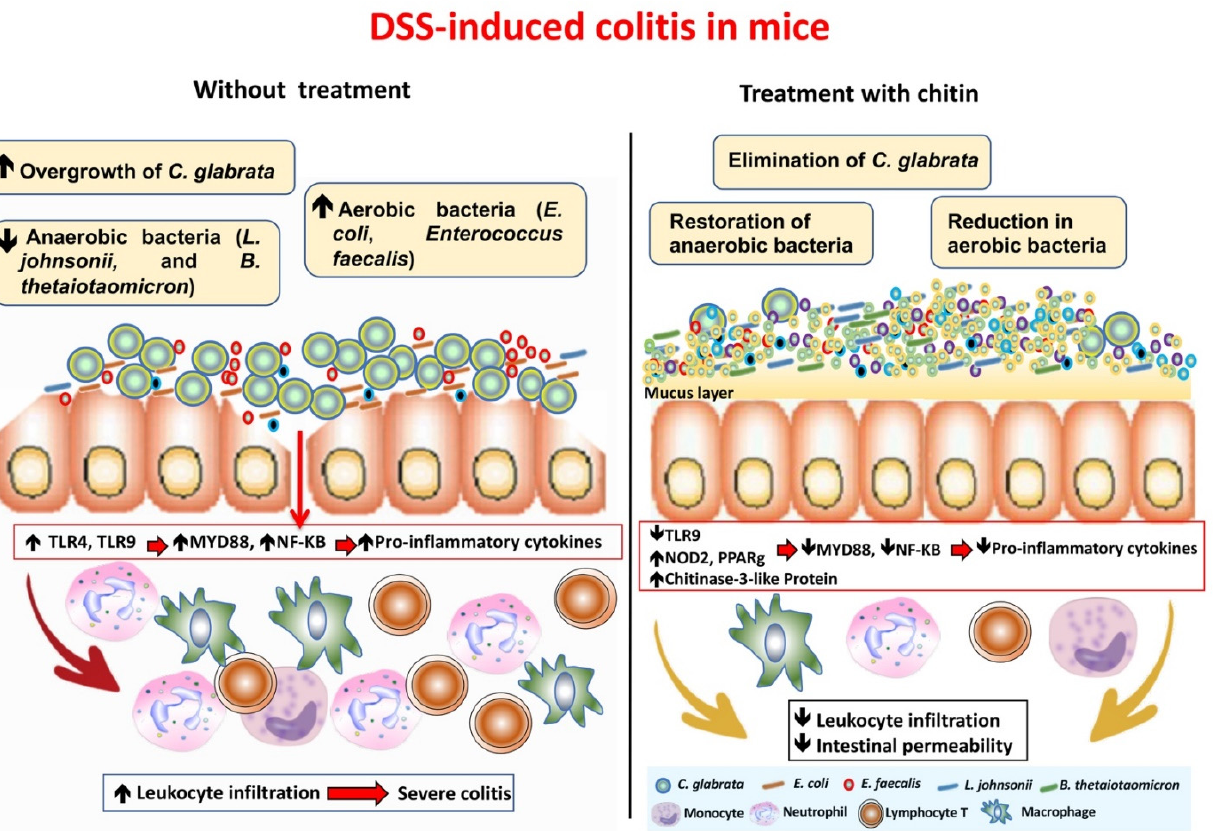
Figure 6. Impact of treatment with fungal chitin on the modulation of intestinal inflammation, C. glabrata overgrowth and the gut microbiota [71].